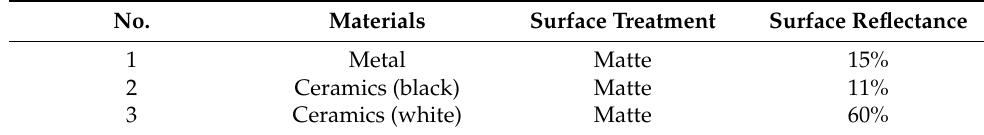
Table 1. The reflectance of standard spheres made by three different materials.